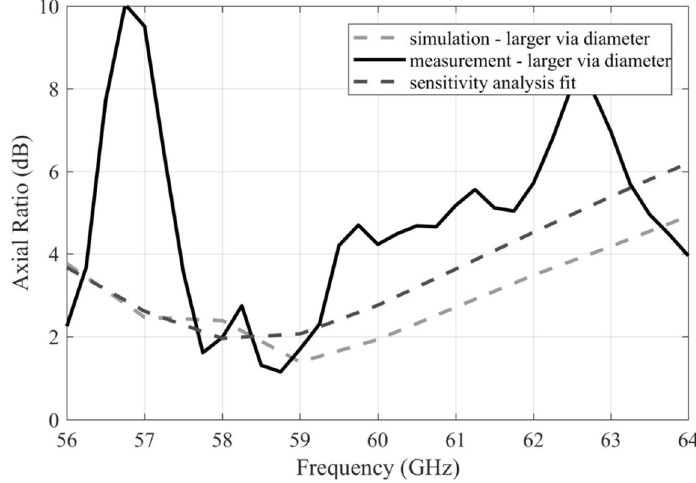
Figure 12. Frequency responses of the AR magnitude for the simulated and measured arrays with larger vias.